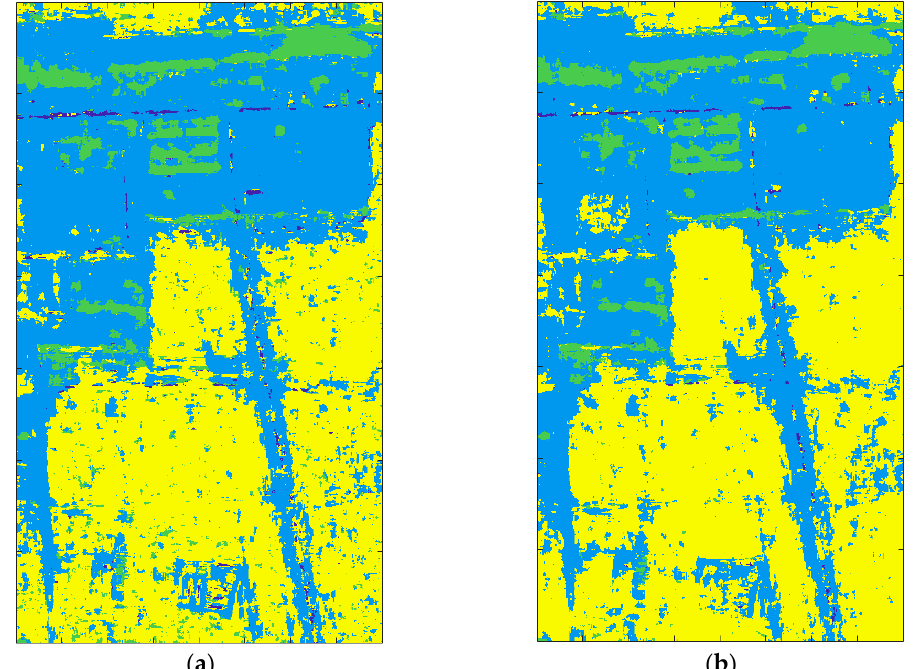
Figure 15. ( a ) Modified average approach result of Baotou City Dataset. ( b ) Our method result of Baotou City Dataset. Table 2. Classification accuracy.